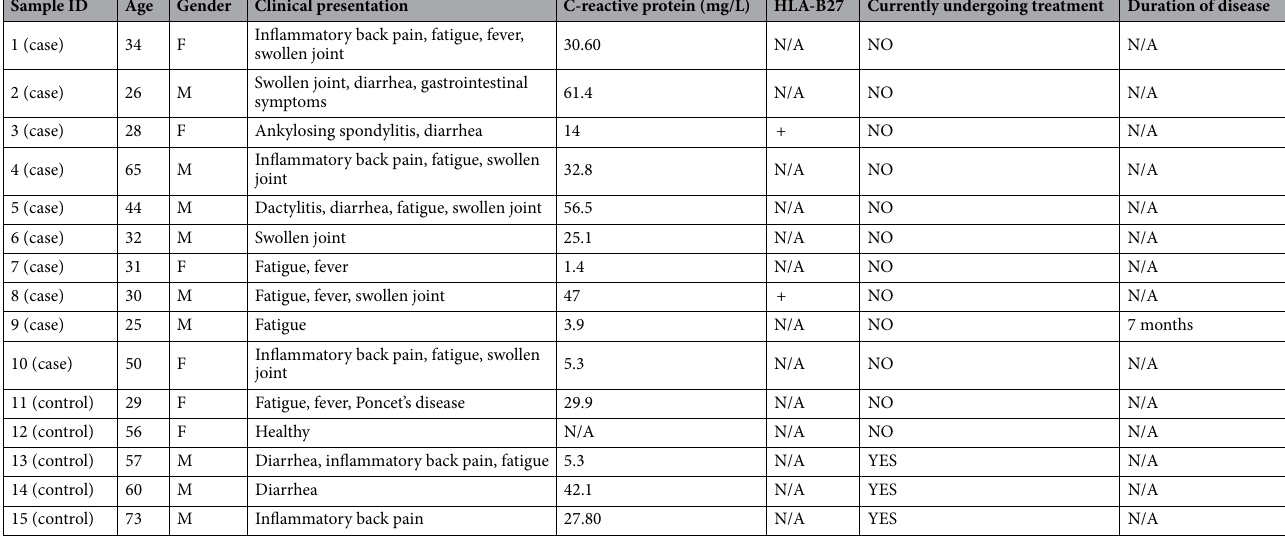
Table 3. Sociodemographic and clinical characteristics of ReA cases vs controls. CRP normal levels (0–3). N/A—data not available.